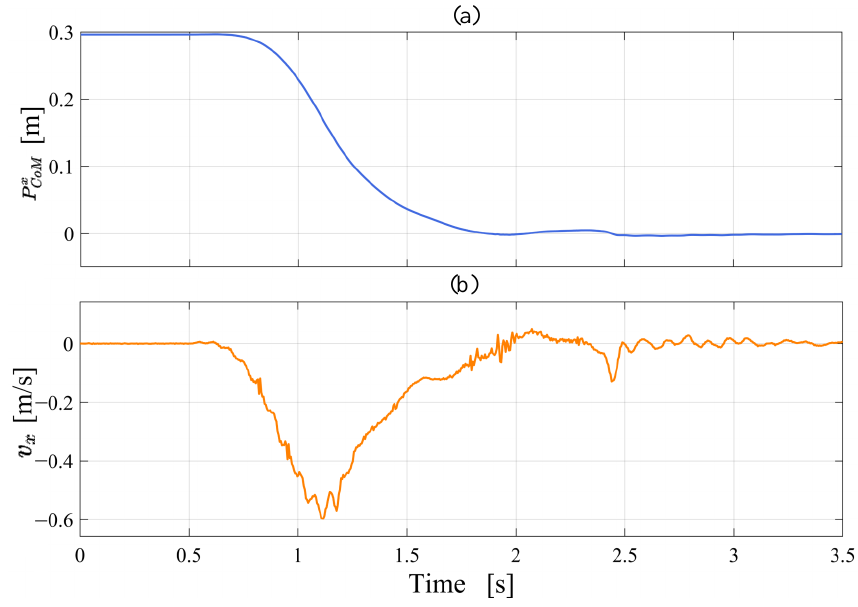
Figure 18. The position and velocity data of the CoM during the modal transition from kneeling to balanced standing ( a , b ). P x is the projection of the distance of the CoM relative to the coordinate CoM system ∑ w on the x -axis and v x is the velocity of the CoM in the x -axis